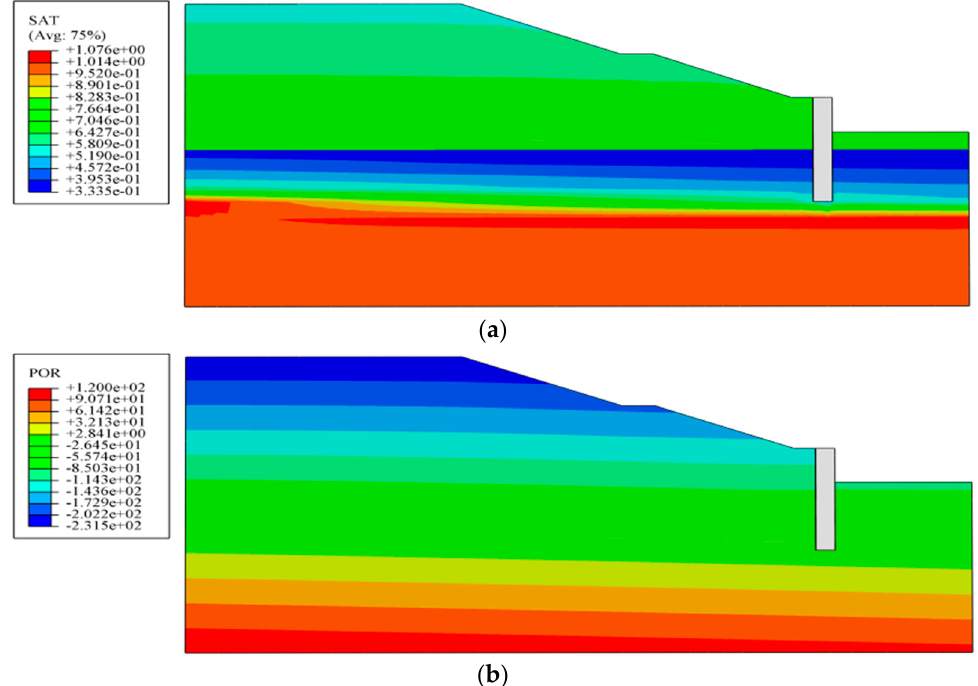
Figure 8. Cutting slope under the steady-state seepage (without snowmelt infiltration): ( a ) the degree of saturation ( S r ); and ( b ) the pore-water pressure (PWP) (unit: